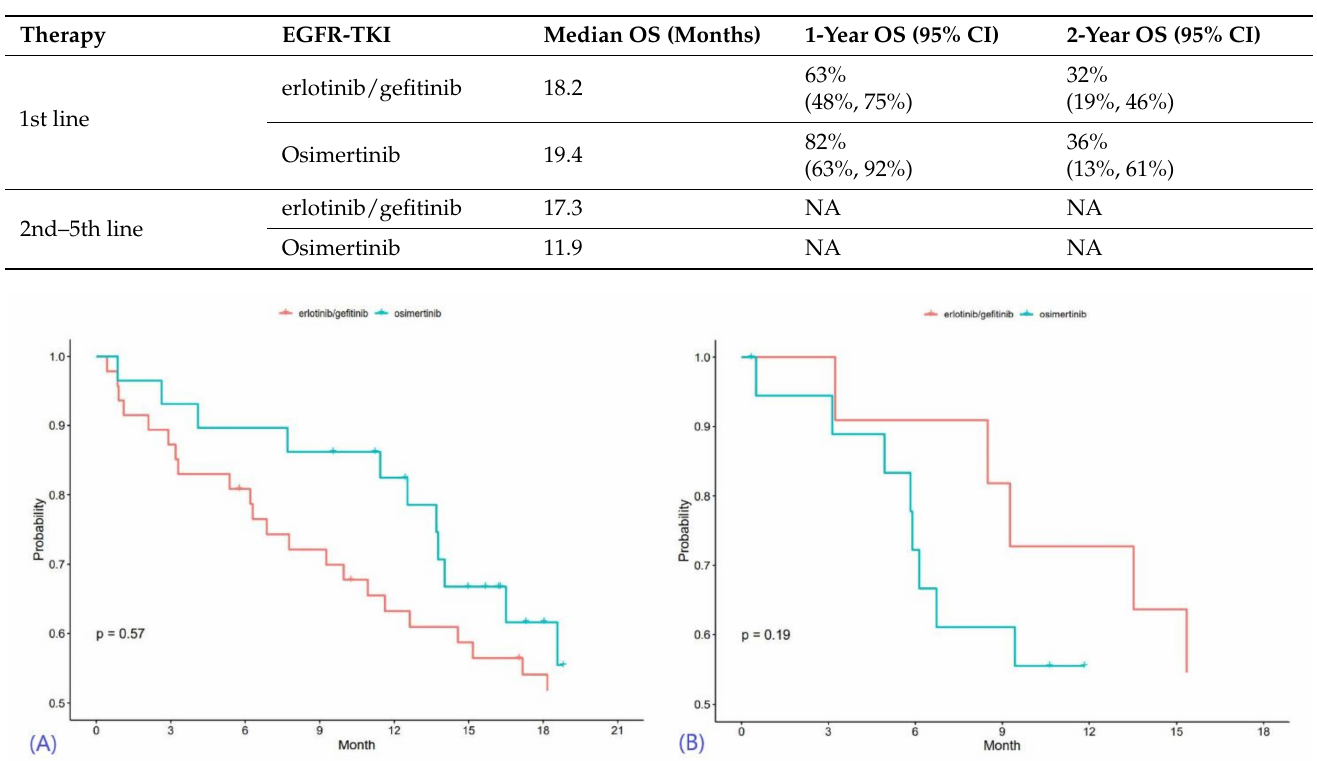
Table 4. Overall survival (OS) of patients with NSCLC brain metastases treated with first-generation and third-generation EGFR-directed Tyrosine Kinase Inhibitors (EGFR-TKIs) in the first line and 2nd-to-5th line treatment settings. NA: Not Available.